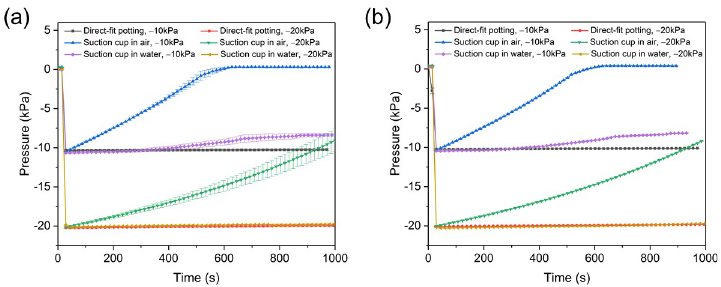
Fig 8. Vacuum pressures recorded during the first 1000 s for potential leakage tests of the 9-port pressure sensing setups. (a) Mean and standard deviation (shown as the error bar) of the pressure at the central port P4 at each time instant for three rounds of measurements, and (b) mean and standard deviation of the mean pressure at all these 9 ports at each time instant for three rounds of measurements.